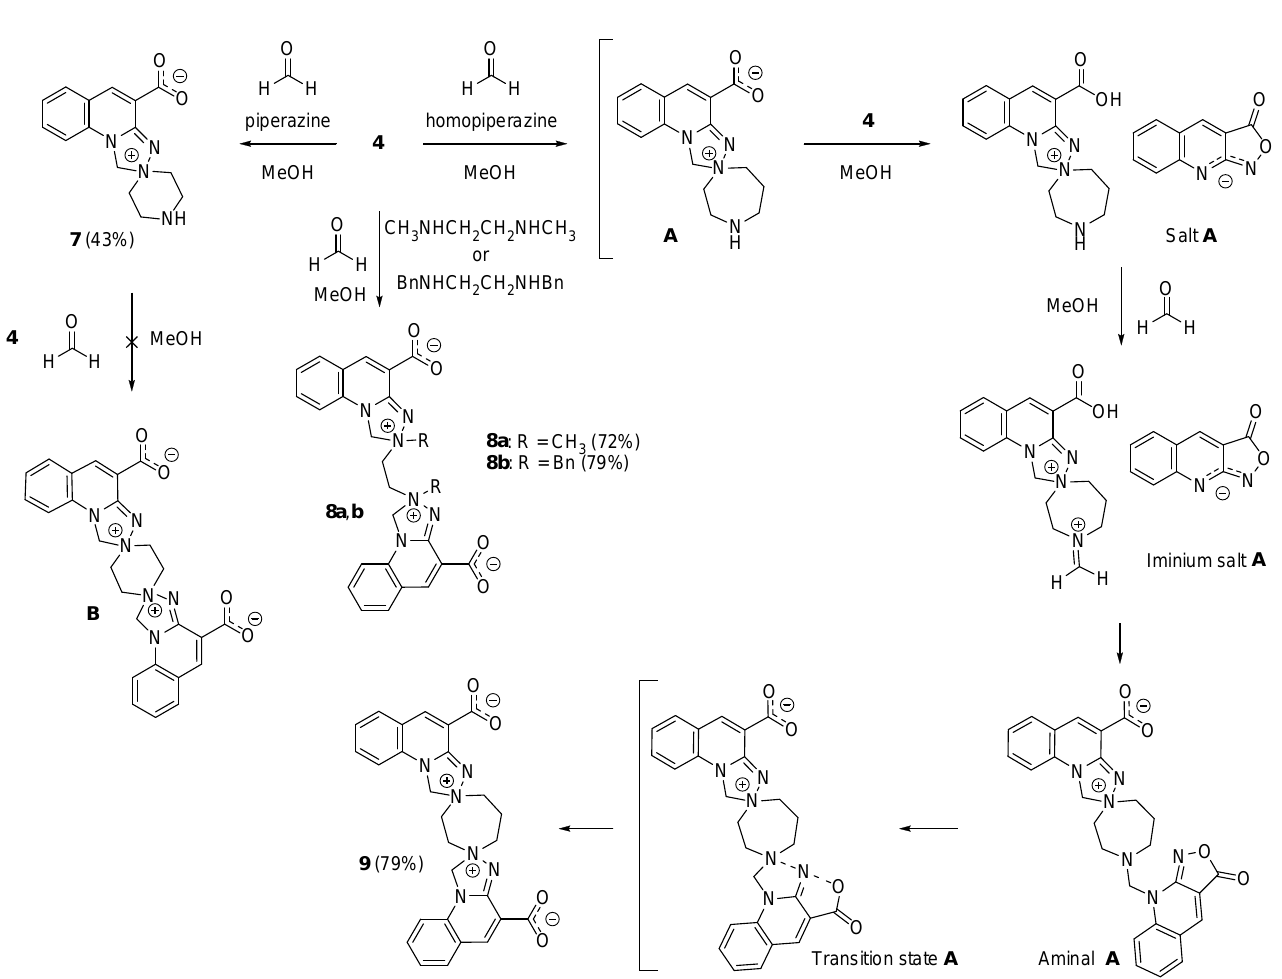
Scheme 4. The reaction of isoxazolone 4 with with iminium salts derived from piperazine, homopiperazine and N 1 , N 2 -dibenzylethane-1,2-diamine.